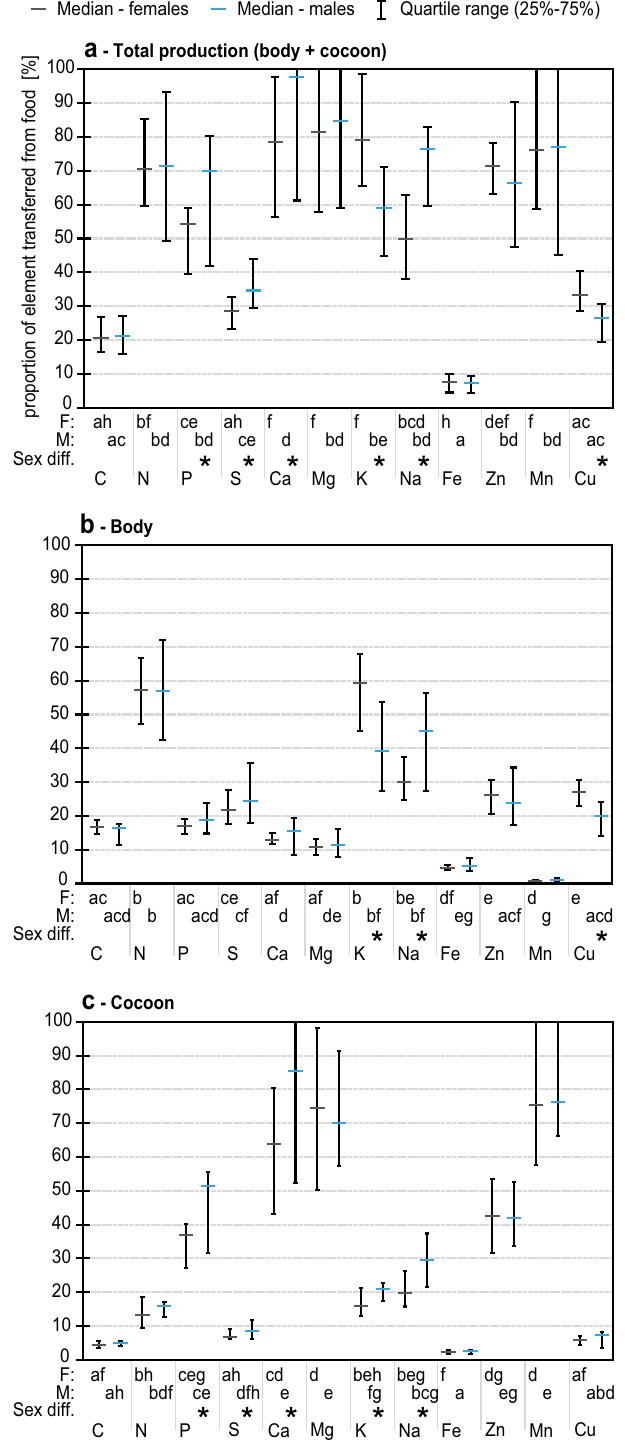
Figure 4. The transfer of matter from pollen to the body and cocoon differs between the sexes and elements. The Kruskal–Wallis test was used to assess the significance (p < 0.05) of differences between the values calculated for each element for a single sex, and the Mann–Whitney U test was used to assess the significance (p < 0.05) of differences between the values calculated for different sexes for each element. Sexual dimorphism is observed for P, S, Ca, K, Na and